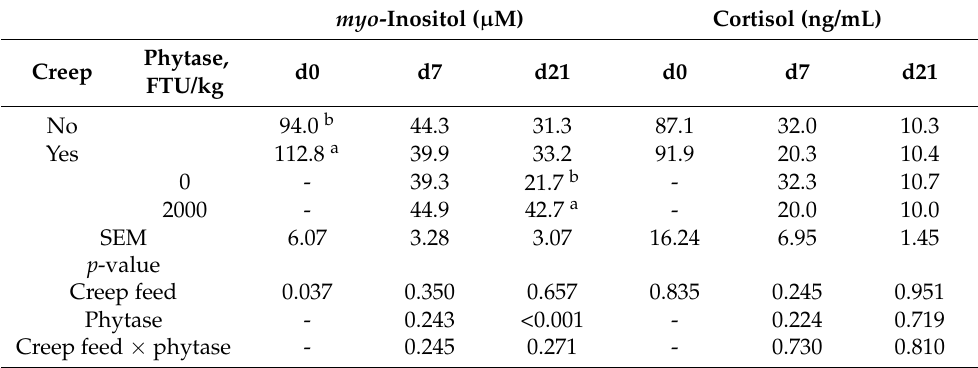
Table 5. Plasma myo -inositol concentrations and cortisol concentrations in weaning pigs. myo -Inositol ( µ